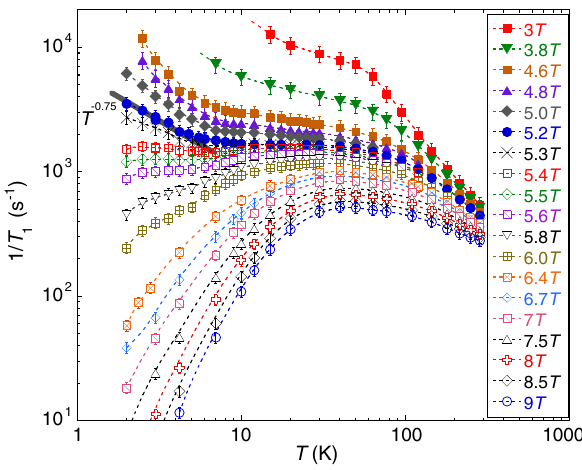
FIG. 5. The temperature dependence of 1 =T 1 in h ⊥ applied along the b axis. All dashed lines interconnecting the data points are guides for the eye. The black solid line through the data points measured at 5.2 Tesla represents a power-law fit, 1 =T ∼ 6 . 2 × 10 3 T − 0 . 75 s − 1 1